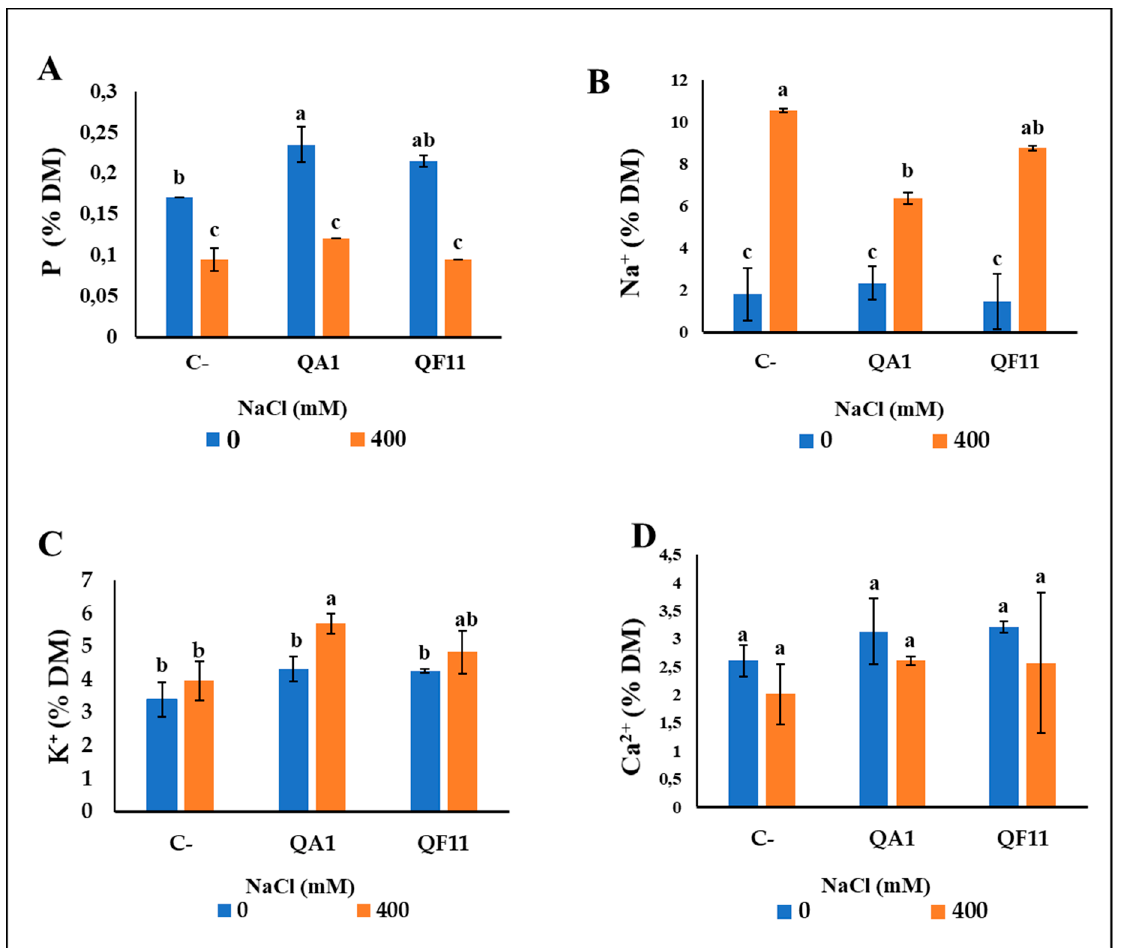
Figure 8. Effect of salt stress induced by NaCl and bacterial inoculation on the uptake of phosphorus (P) and salt ions by quinoa plants. ( A ) P ( B ) Na + ( C ) K + ( D ) Ca 2+ . The values represent means of replicates ( n = 4) ± standard deviations. The different letters in superscript (a, b, c…) indicate the statistically significant difference at 95% between treatments.